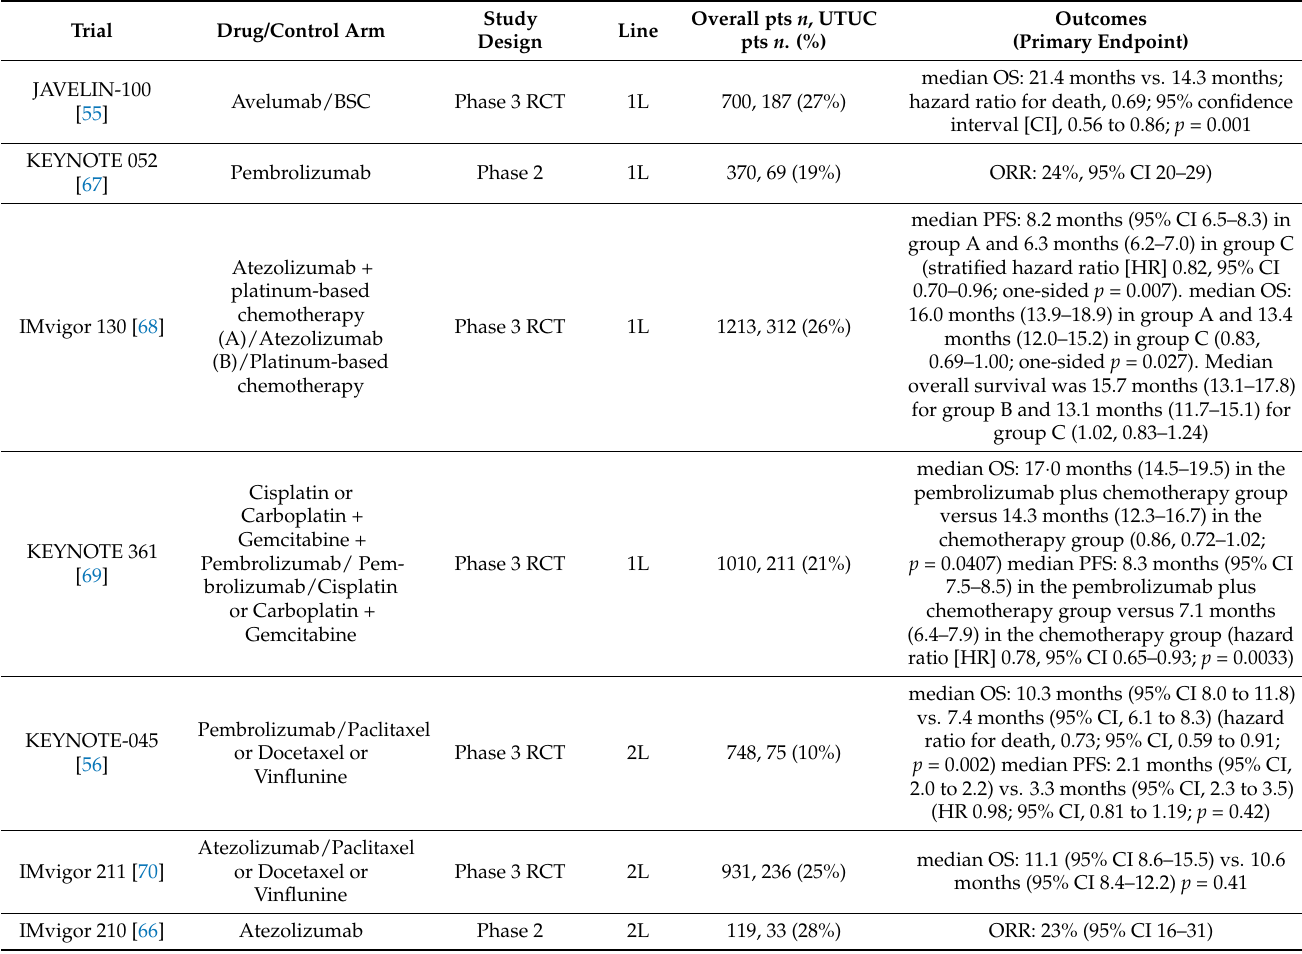
Table 2. Studies assessing ICI in patients with locally advanced or metastatic UC (only trials reporting data of UTUC patients were